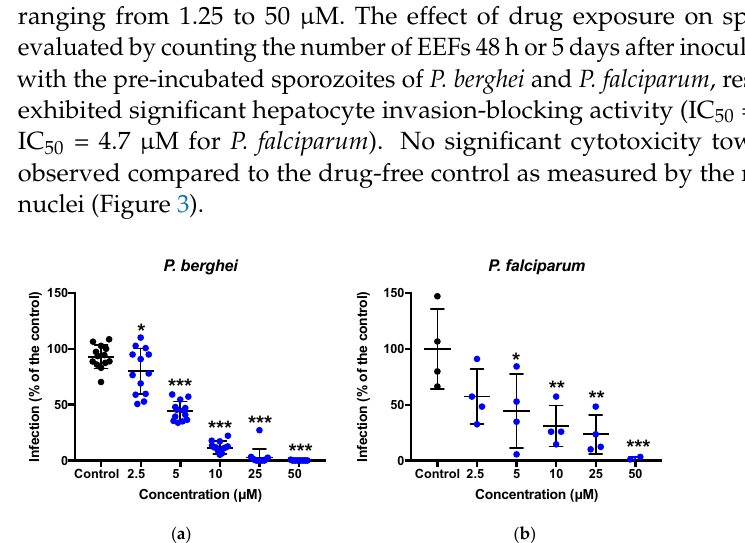
Figure 2. Exposure to MB during Plasmodium mosquito stage development shows a moderate impact on oocyst numbers. Preliminary P. berghei -infected mosquitoes were divided into three groups that received secondary blood meals on anesthetized mice treated with 0 (control, black dot), 50 (light blue dot) and 100 (dark blue dot) mg/kg MB 3 days ( a ) and 6 days ( b ) pi. The infection intensity is presented as the number of oocysts per midgut (black dots). The black lines represent the mean and standard deviation. Data are represented from two independent experiments. *** p = 0.005 when compared to the control by t -test.